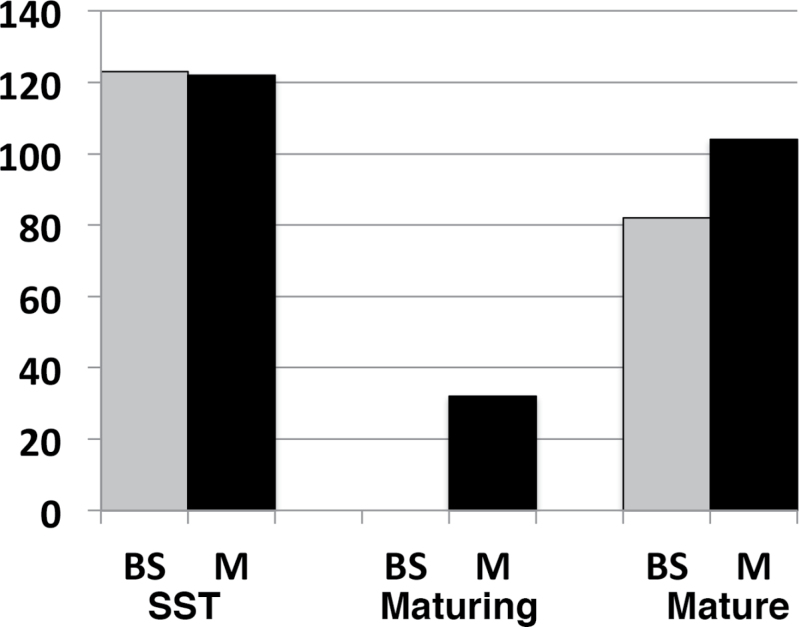
DE genes expressed in only one stage. DE genes that were expressed in only one of the three stages are plotted for each cell type. The number is highest for the SST stage and smallest for maturing stage for both cell types.